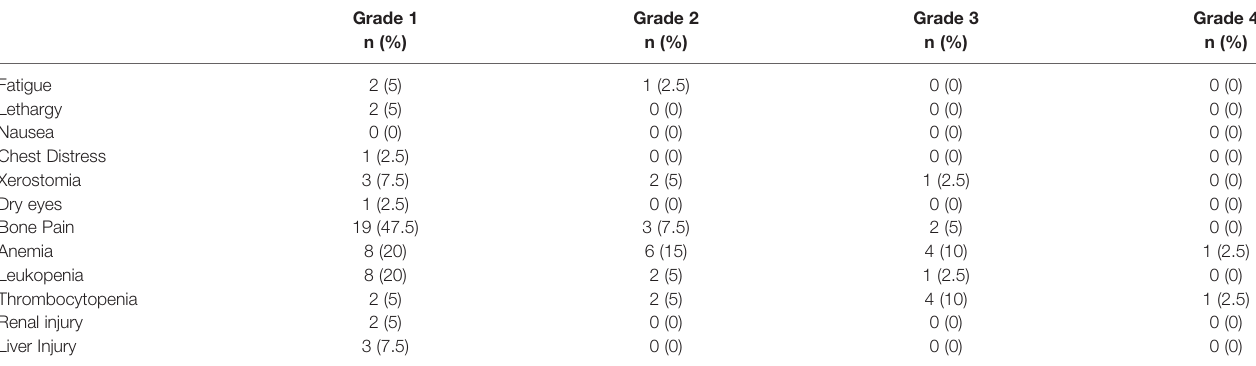
TABLE 3 | Treatment related toxicity occurring up to 12 weeks after treatment